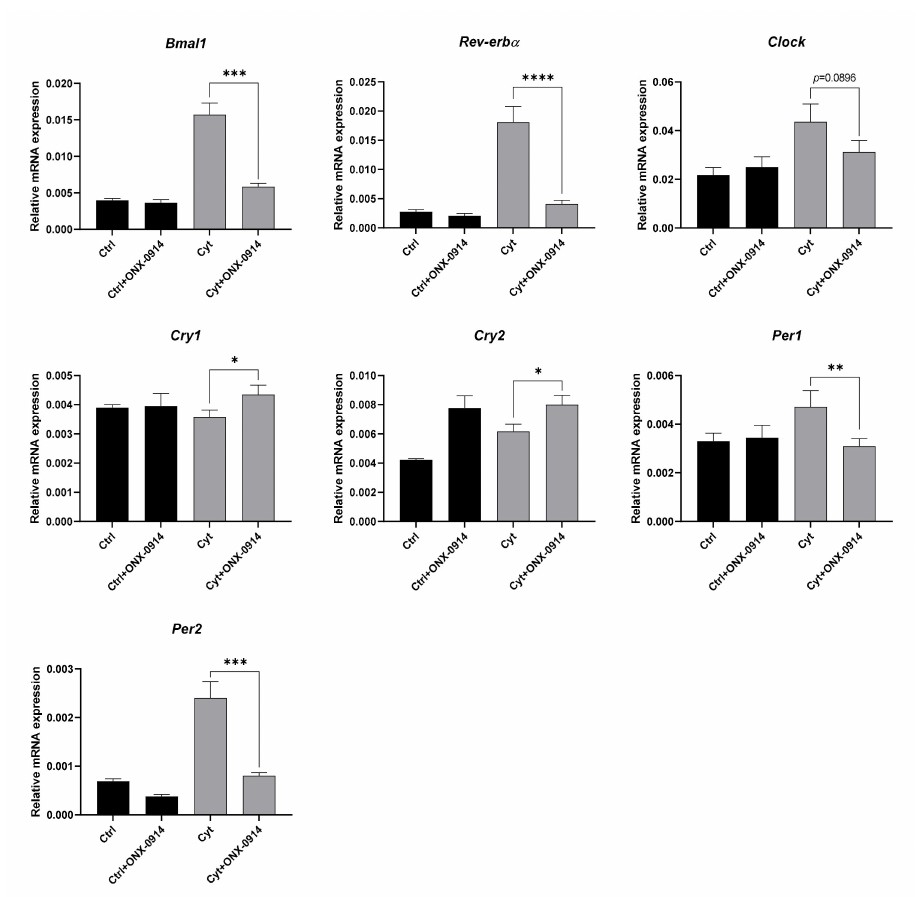
Figure 9. Inhibition of the inducible proteasome reverts cytokine-induced changes in clock gene expression in non- synchronized INS-1 cells. INS-1 cells were treated with 50 nM ONX-0914 for 1 h preincubation followed by 12 h coincubation with or without 150 pg/mL mouse IL-1 β + 0.1 ng/mL rat IFN- γ (Cyt). Relative mRNA expression was calculated using Ppia as reference gene. Values are means ± SEM ( n = 5). Statistics are paired Student’s t -test. Significance levels were annotated as follows: * = p -value < 0.05, ** = p -value < 0.01, *** = p -value < 0.001, **** = p -value <